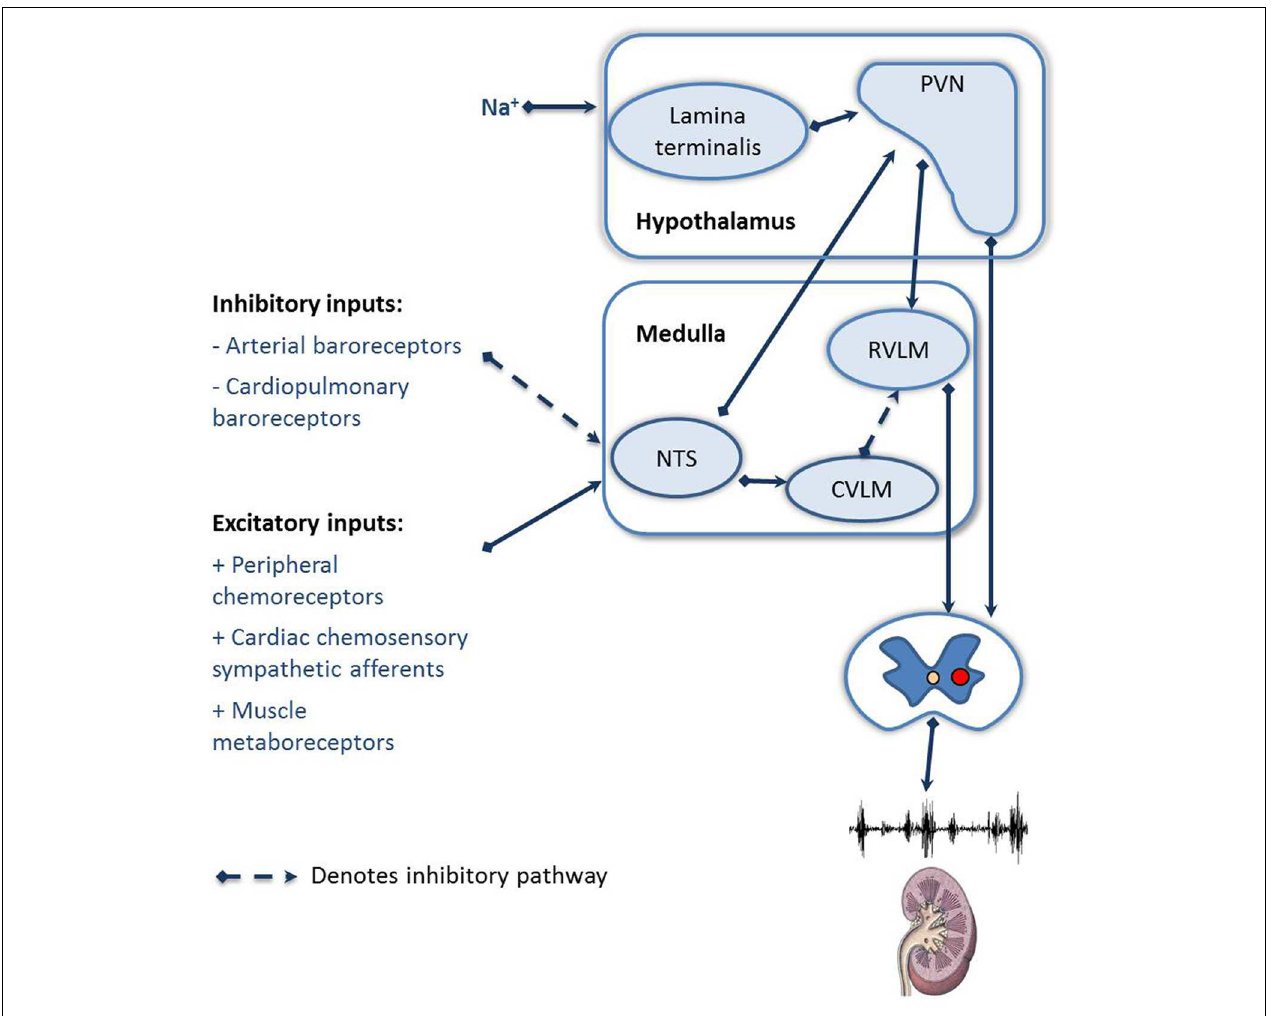
FIGURE 2 | Schematic showing the afferent reflexes which modulate renal sympathetic nerve activity during heart failure. NTS, Nucleus of the solitary tract; RVLM, rostral ventral lateral medulla; CVLM, caudal ventral lateral medulla; PVN, paraventricular nucleus of the